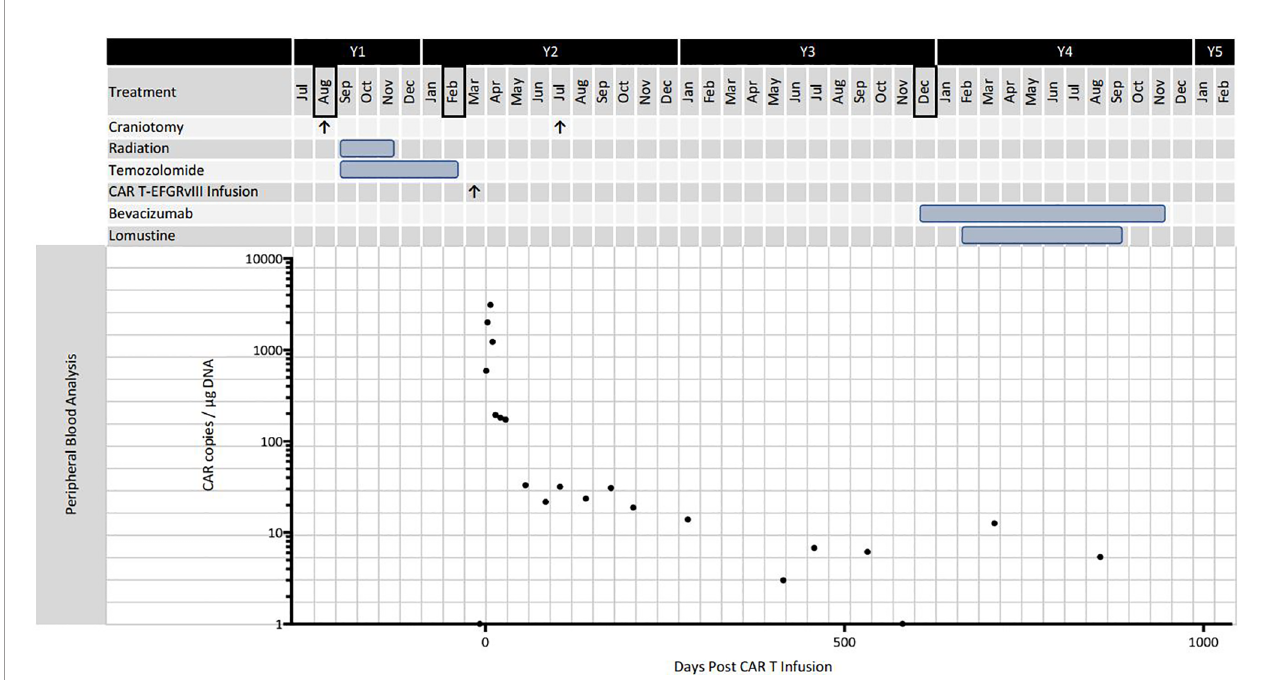
FIGURE 2 | Timeline of disease progression and treatment. Black bordered months indicate diagnosis or de fi nitive progression on surveillance MRI. The graph shows CAR T-EGFRvIII levels in the peripheral blood as measured by